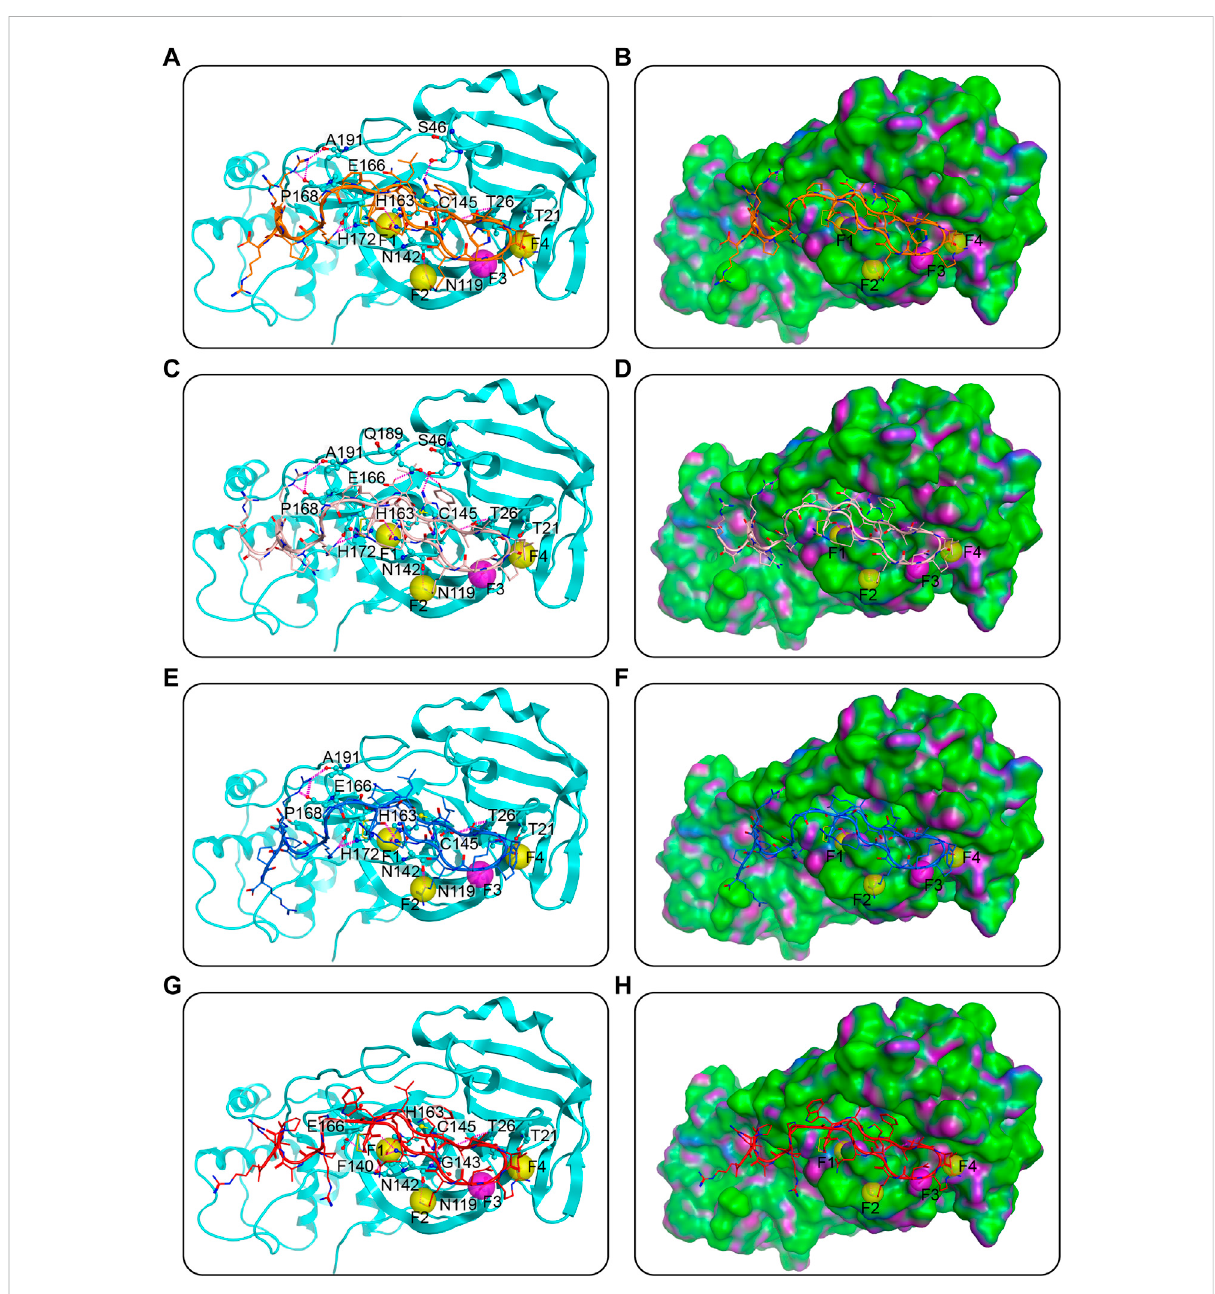
FIGURE 3 Predicted docking poses of MNs 1-4 at the Mpro active site. (A) , (C) , (E) , and (G) are MNs 1-4, respectively, and (B) , (D) , (F) , and (H) are their corresponding surface plots. Peptides are represented by different colors (orange for MN-1, pink for MN-2, blue for MN-3, and red for MN-4), and Mpro is color-coded by cyan-blue. Pharmacophore features of Mpro are represented as spheres. The hydrogen bonds were indicated by purple dotted lines. The surface of the Mpro is plotted by H-bonding (purple), hydrophobicity (green), and mild polar (blue)